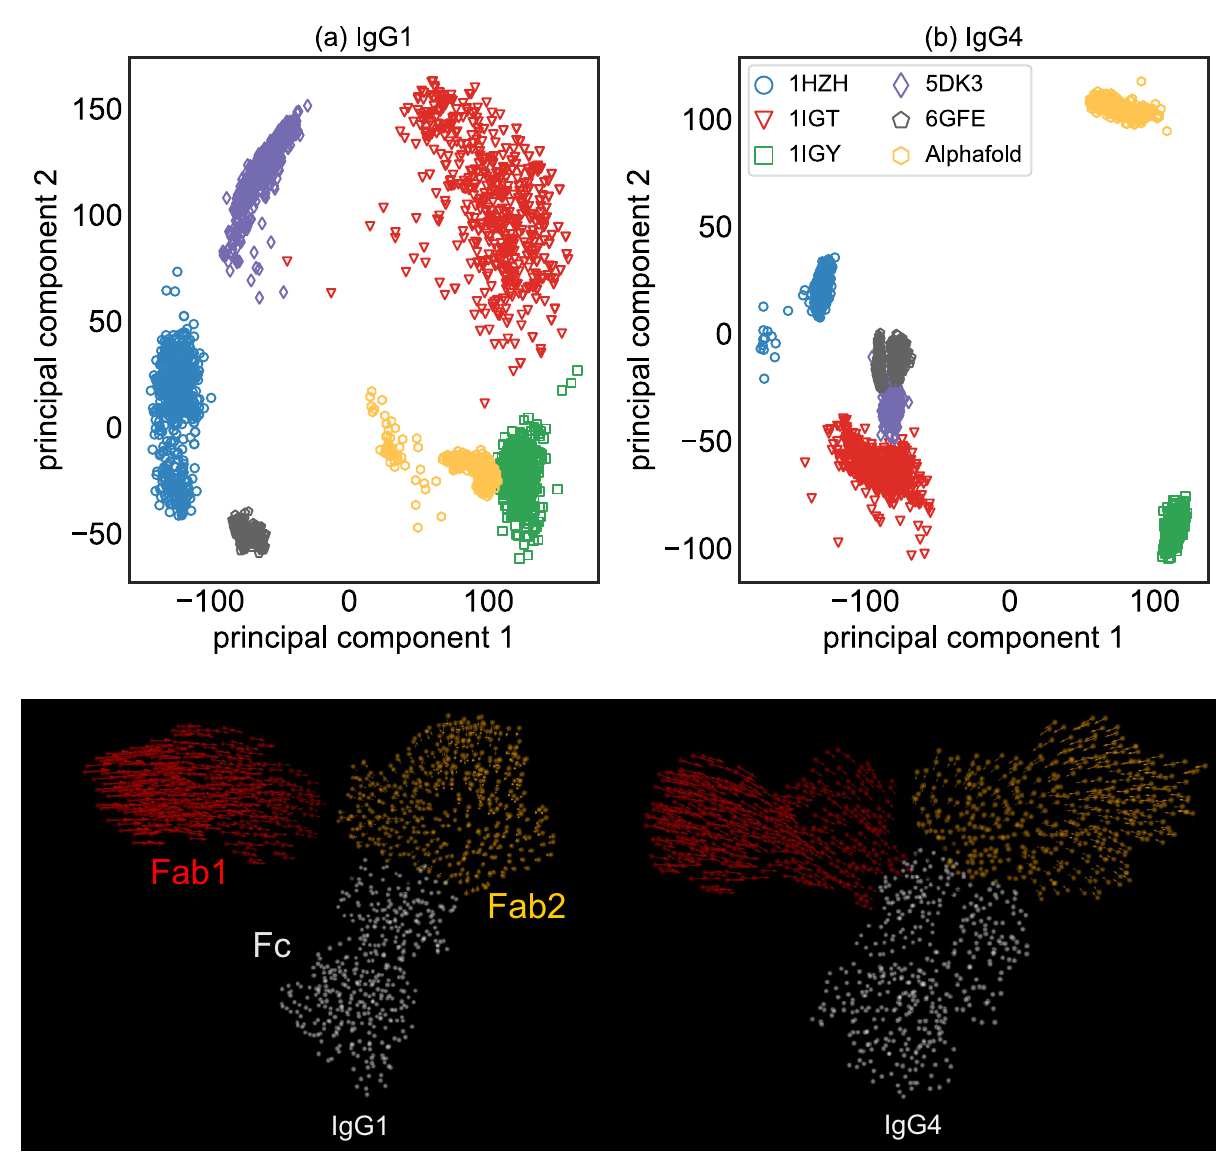
Figure 4. Projections of six independent trajectories (spawned from five different crystal structures + from the relaxed structure predicted by Alphafold), for ( a ) IgG1 and ( b ) IgG4, along their first two principal directions. Principal Component (PC) analysis was performed using the positions of all alpha carbon atoms over all trajectories. The conformational states accessed by each structure again displays minimal overlap in the PC space. The images below display the first principal direction for the 1HZH structure. The length of the arrows at each alpha carbon (shown as spheres) is directly proportional to the atom’s contributions to the principal motion. Our analysis shows that the first principal motion is more concentrated on the Fab1 domain, that shows zero non-covalent interactions with the Fc